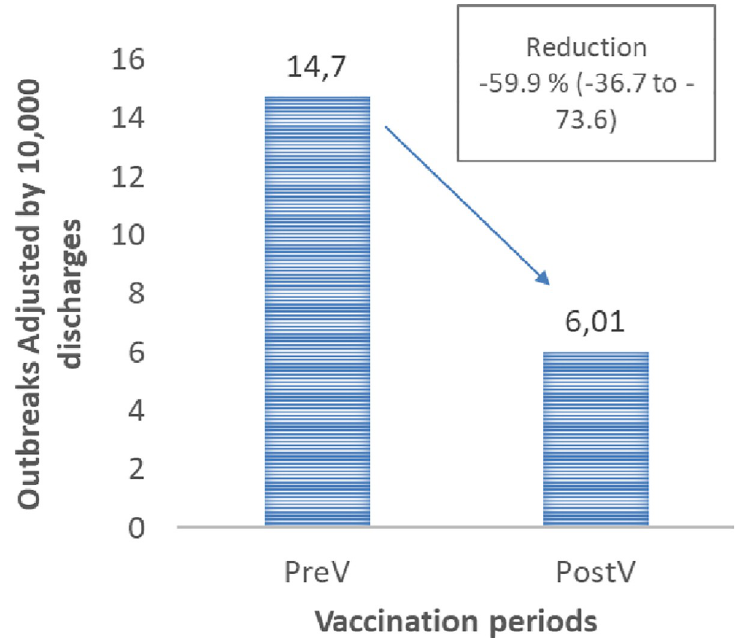
Fig 2. Outbreaks adjusted by 10,000